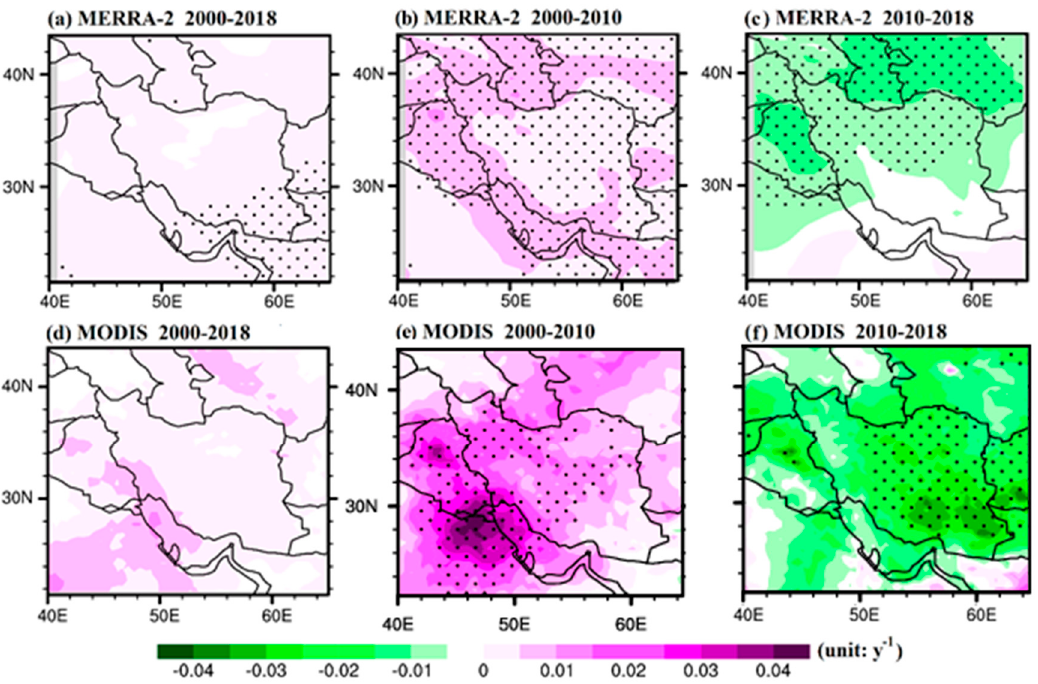
Figure 4. Spatial distributions of the winter (DJF) AOD 550 trends from the MERRA-2 ( a – c ) and MODIS ( d – f ) datasets during the selected periods. The black dots indicate the pixels with significant trends at a 95% confidence level ( p < 0.05).